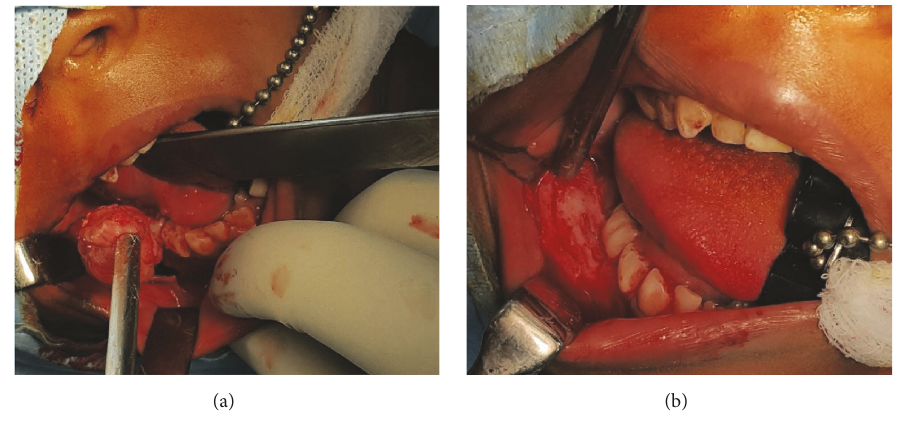
Figure 3: Surgical enucleation of the lesion under general anesthesia.